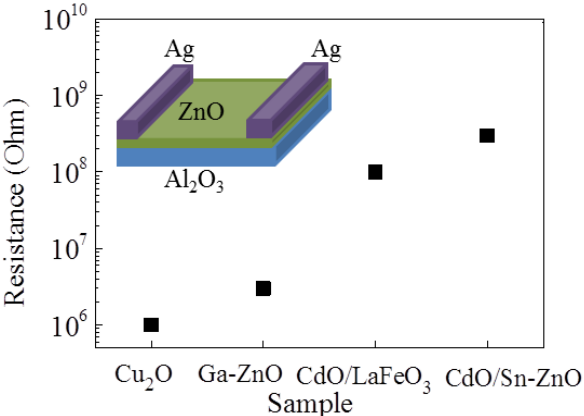
Figure 8. Gas sensor resistance selection rules for effective p + n sensor arrays.